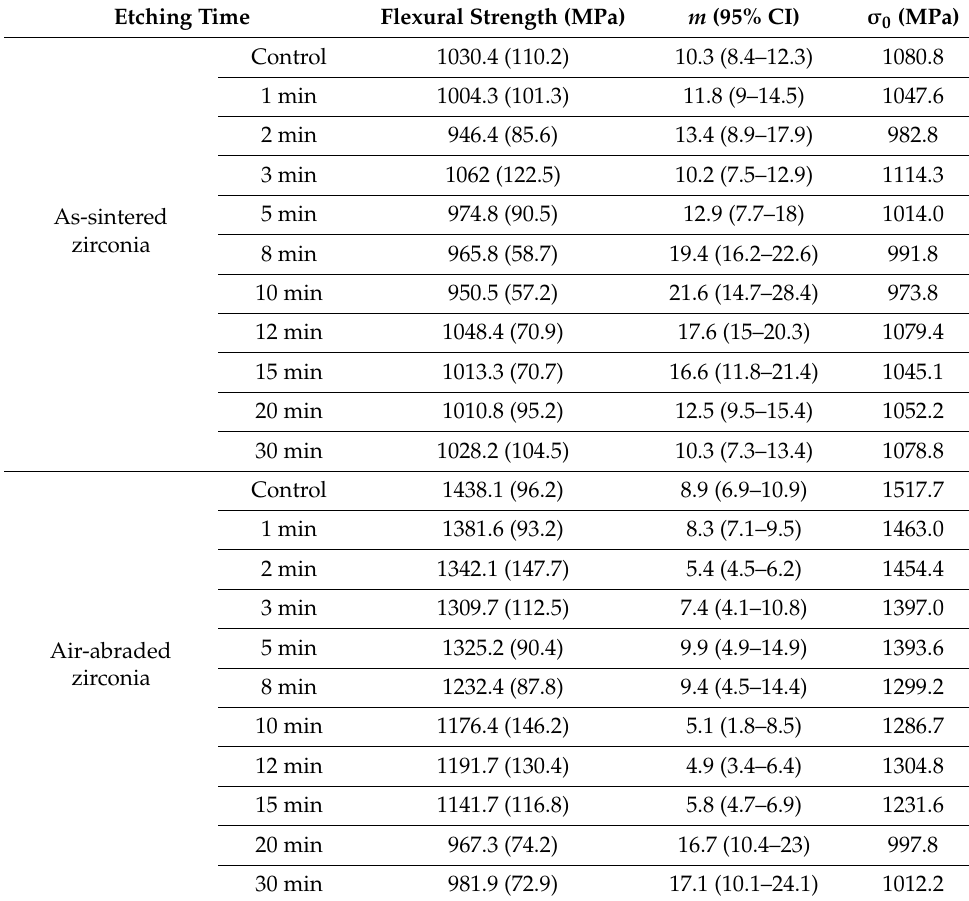
Table 3. Mean and standard deviation of flexural strength and Weibull parameters of as-sintered and air-abraded zirconia specimens according to etching treatment